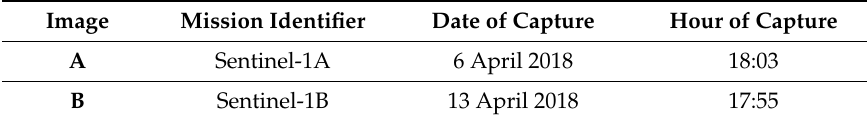
Table 3. Characteristics of the Sentinel-1 SAR images used in the